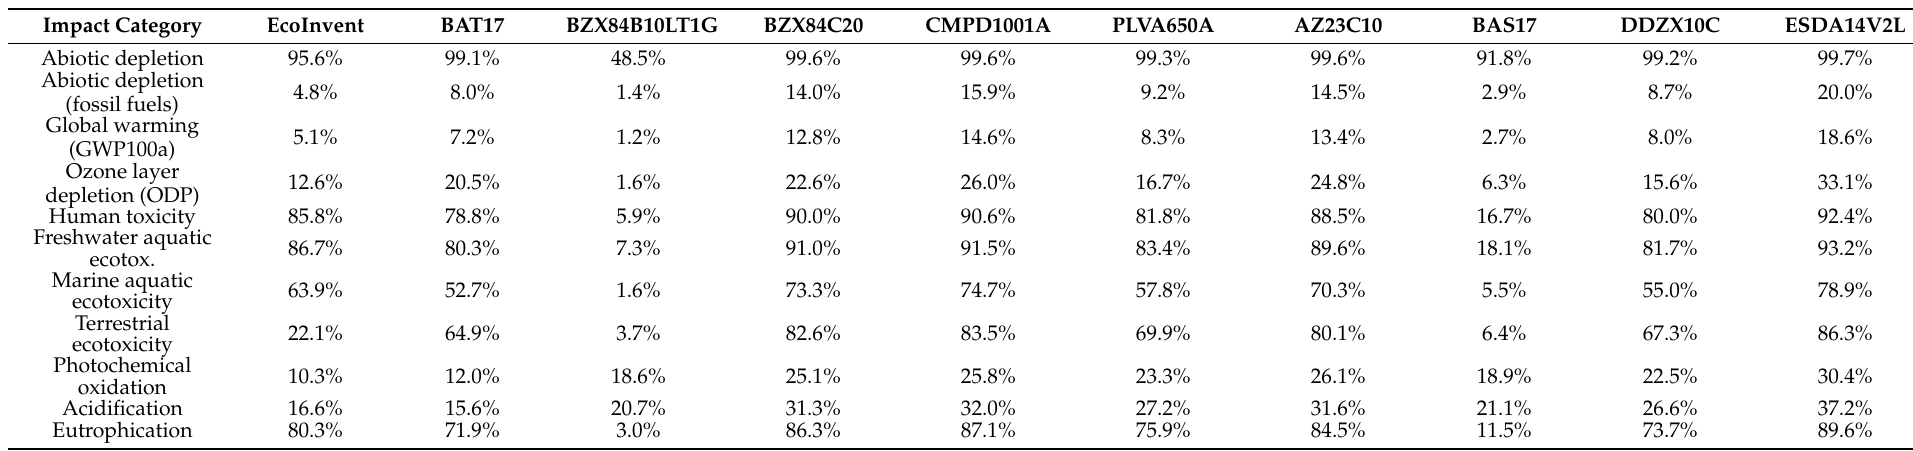
Table 4. Percentage of environmental impact due to materials.